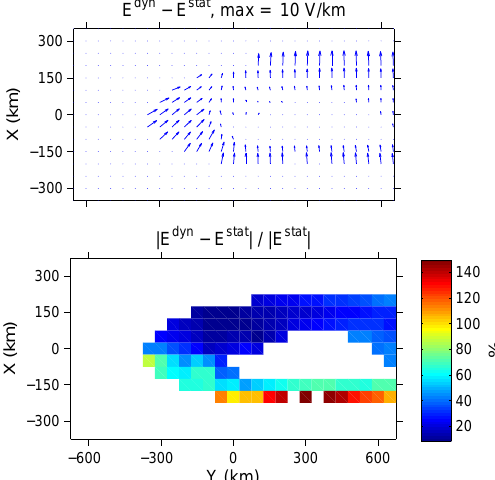
Fig. 14. Results for the WTS model. Upper panel shows the dif- ference between the electric fields obtained from static ( E stat ) and electrodynamic ( E dyn ) solvers. The lower panel shows the percent- age difference in electric field magnitude. Only those areas where | E stat | > 5Vkm − 1 and 6 H > 5S are shown. Reproduced from Vanham¨aki